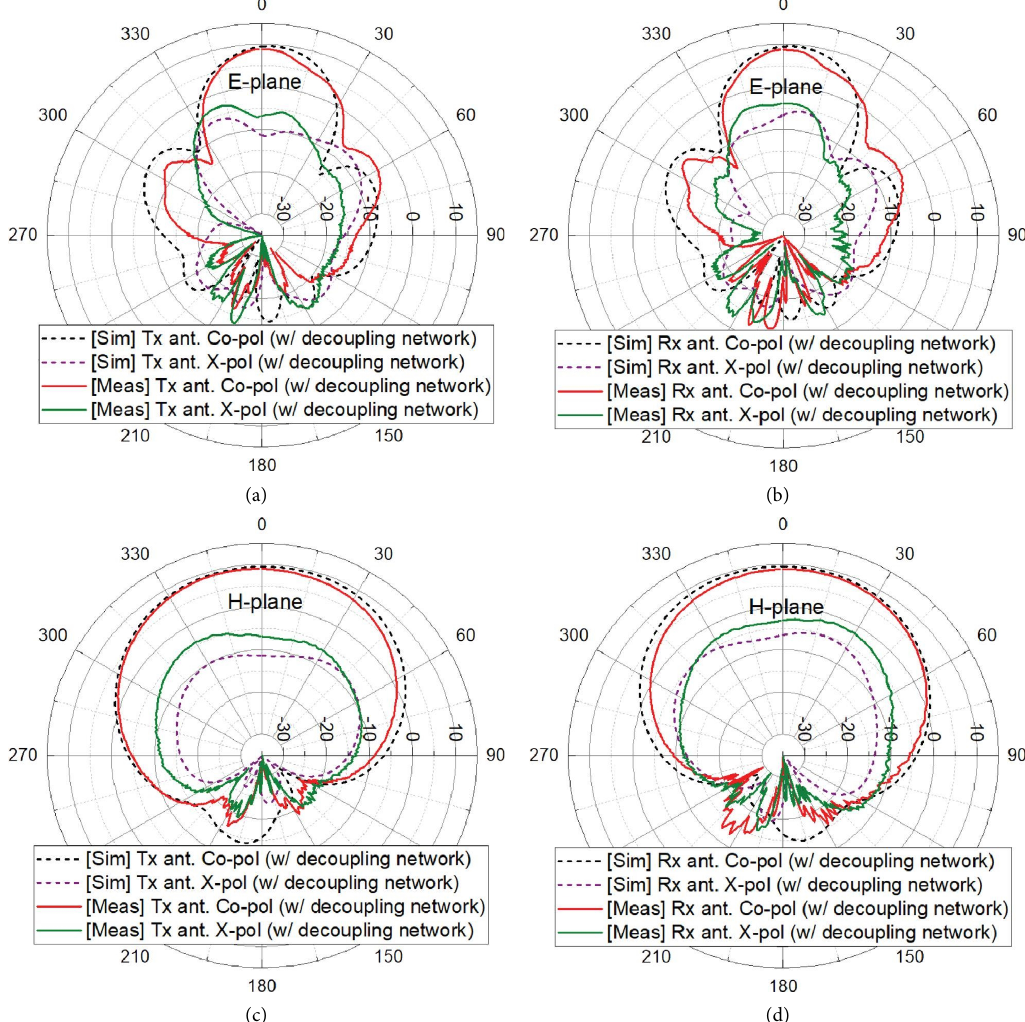
Figure 18: Measured beam patterns of Tx/Rx antennas with the decoupling network at the frequency of 24.1GHz: (a) E-plane of Tx antenna, (b) E-plane of Rx antenna, (c) H-plane of Tx antenna, and (d) H-plane of Rx